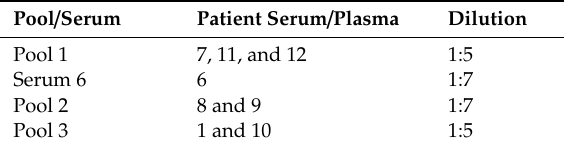
Table 2. Pooling of sera and plasma for IgE-western blot and used dilution. Membrane number indicates the membrane that was incubated with the specific pooled